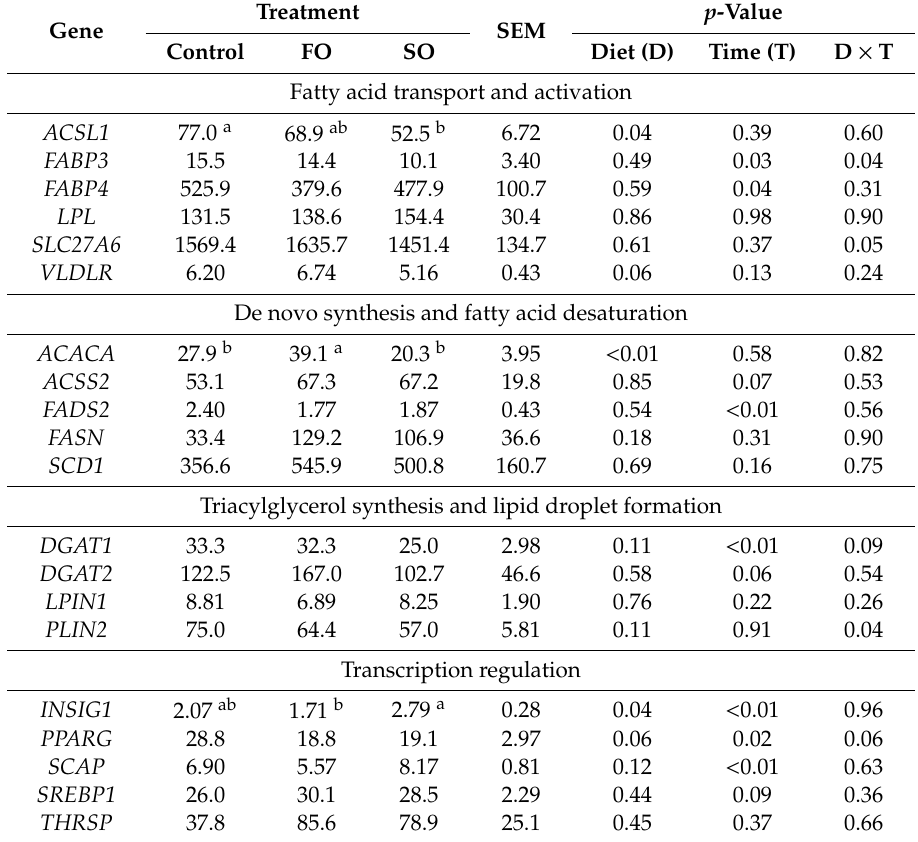
Table 3. Transcript abundance of genes related to lipid metabolism in subcutaneous adipose tissue (SAT) of cows supplemented with soybean oil (SO), and fish oil (FO).